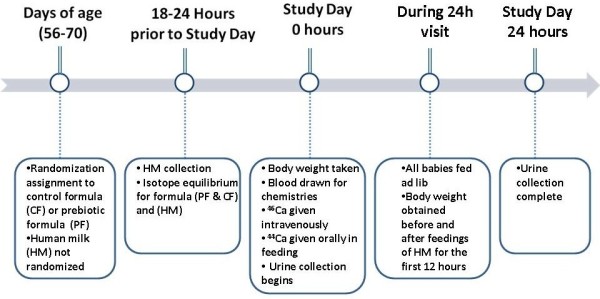
Timeline of Infant Evaluation.